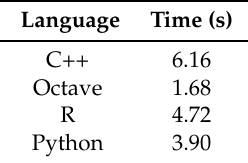
Figure 2. Outputs of the Monte Carlo simulations obtained by the script run in GNU Octave. The simulation times performed using the enumerated languages differs a bit—cf. Table 3. Table 3. Comparison of simulation